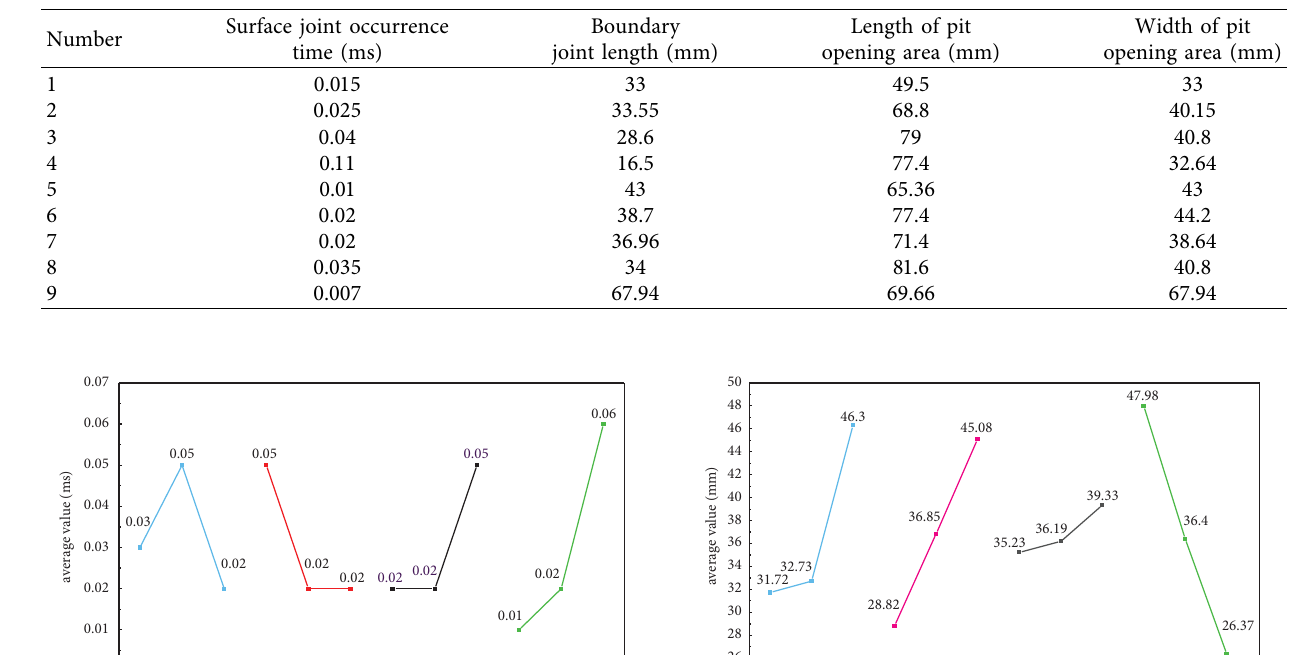
Table 9: Results of coplanar double fragment penetration into the open pit area.